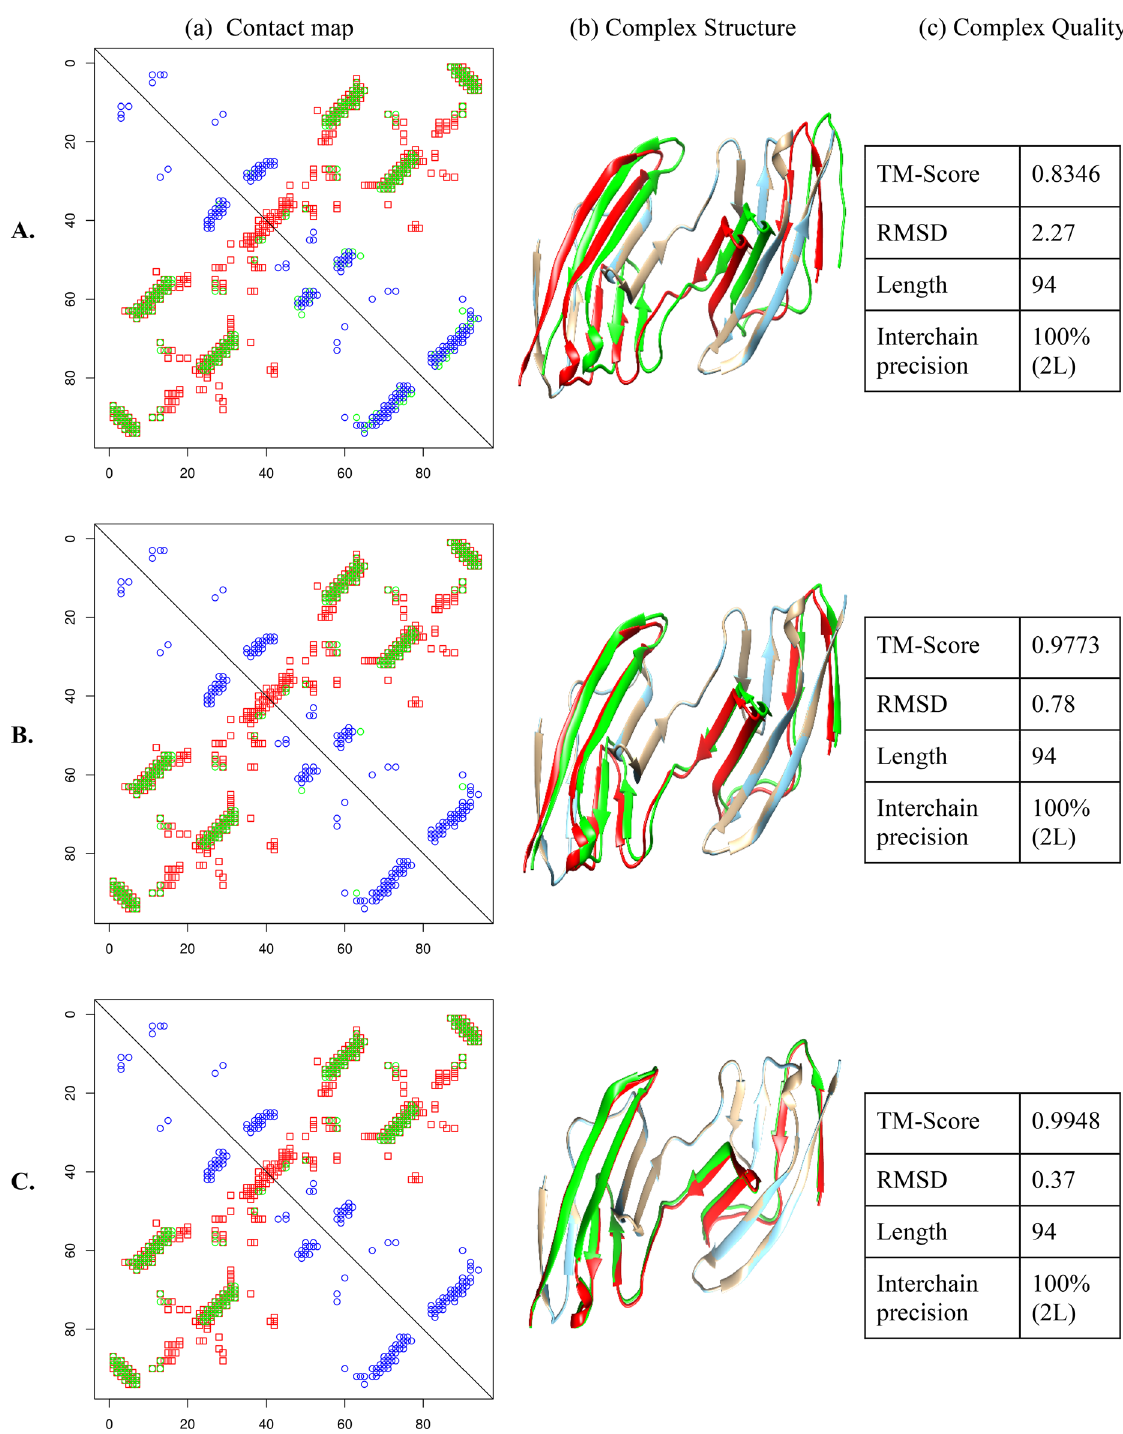
Figure 5. Rows A., B., and C. correspond to relax removal values 0, 1, and 2, respectively. Columns (a) show the contact maps, (b) shows the complex structure comparison, and (c) shows the quality of the complex structures for relevant relax removals A., B., and C. The contact map comparisons are between true intrachain (blue), predicted interchain (green), and true interchain (red) contacts for 1A64. The green dots that overlap with the red dots are correct interchain contact predictions. These contacts were used to reconstruct the complex structure using Con_Complex. (b) shows the comparison between true homodimer structure and the structure derived from Con_Complex. (Golden: original chain A; Cyan: reconstructed chain A; red: original chain B; green: reconstructed chain B) The TM-score and RMSDs were obtained using TM-Align and shown in column (c)